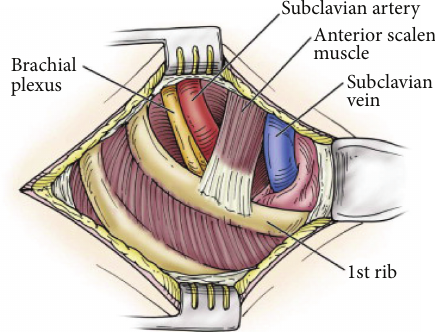
Figure 1: Anatomy of the thoracic outlet (reprinted with permission of Elsevier; see [8]).